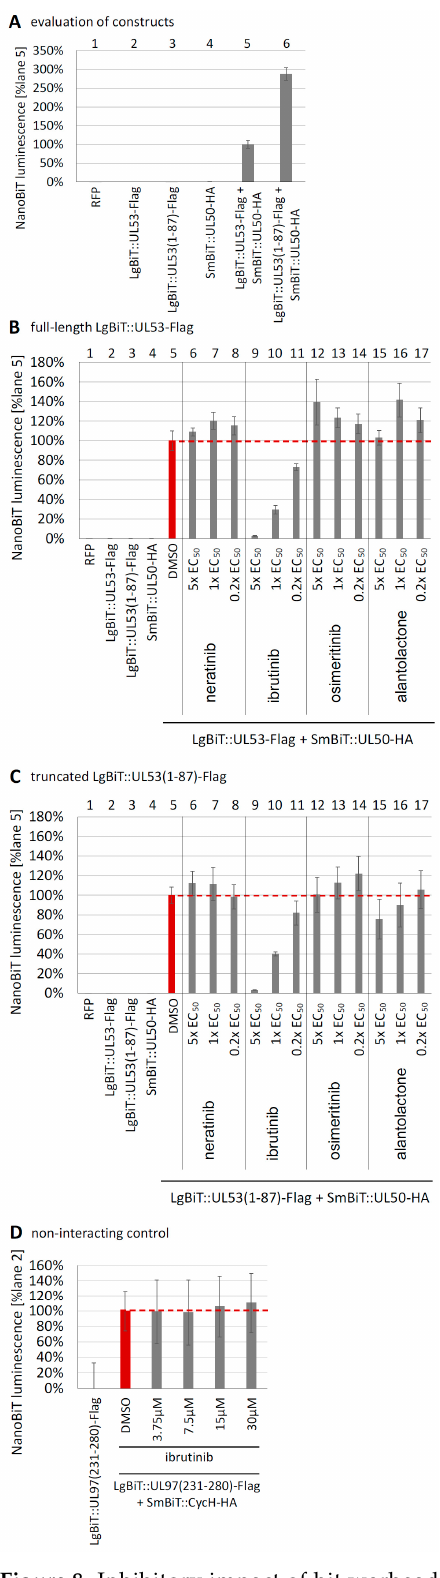
Figure 8. Inhibitory impact of hit warheads on the HCMV core NEC interaction. ( A ) 293T cells were transiently transfected with the constructs LgBiT::UL53-Flag, LgBiT::UL53(1–87)-Flag or SmBiT::UL50-HA for assaying in the NanoBiT system. At 1 d p.t., biological triplicates of cells were transferred into a 96-well plate. After addition of NanoGlo Live Cell Reagent, measurements were immediately performed to quantify luminescence for 2 h. Each of the constructs,